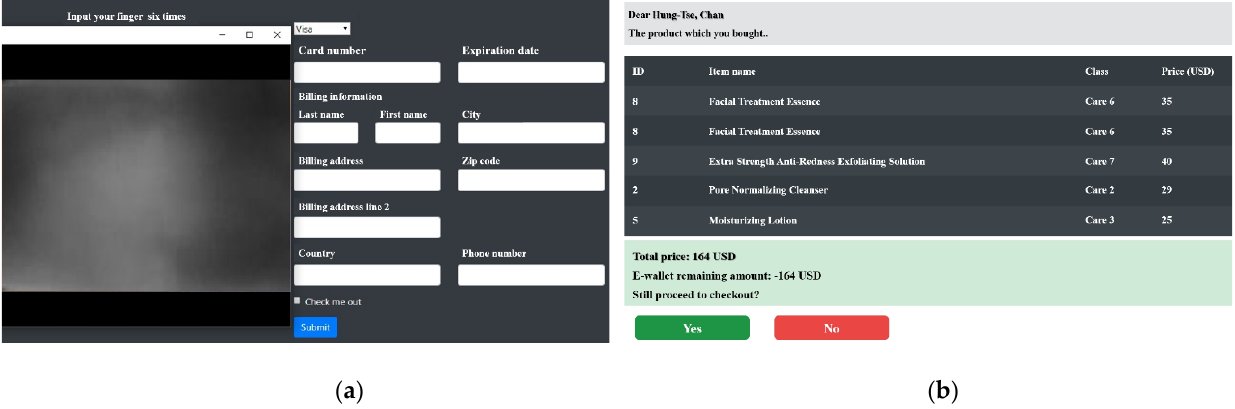
Figure 8. Finger-vein identification system: ( a ) Membership registration interface; ( b ) Electronic payment interface.